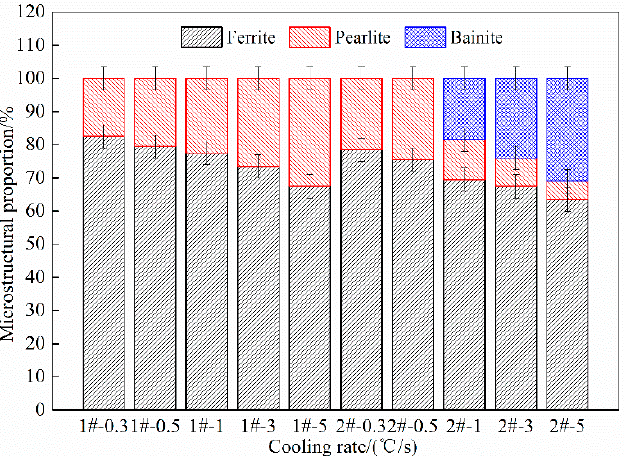
Figure 9. Microstructure proportions of steels 1# and 2# at different cooling